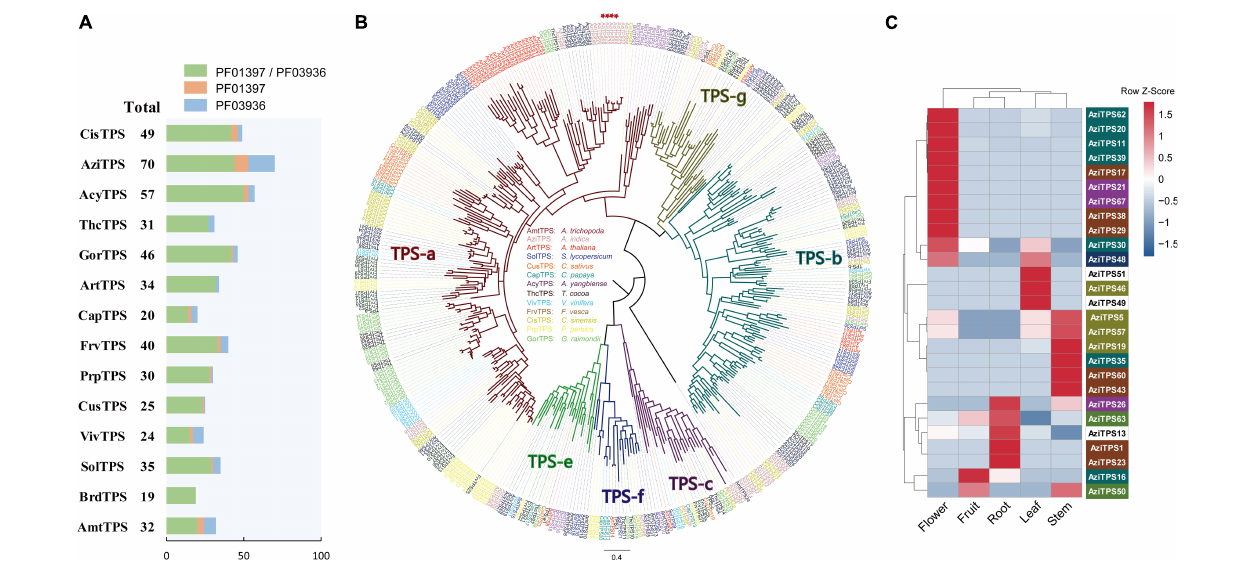
FIGURE 5 | Analysis of TPS gene family in A. indica . (A) Statistics of predicted TPS genes in A. indica and other 13 plants. (B) Phylogenetic analysis of TPS family members based on the protein sequences. A Maximum-Likelihood (ML) tree was generated from an alignment of 409 TPS protein sequences, comprising 403 putative TPSs from A. indica and other 13 plants (the remaining TPS genes were too short for meaningful alignment) and other six reported TPS genes belonged to TPS- a (AAX16121.1), b (AAQ16588.1), c (AAD04292.1), e (Q39548.1), f (Q93YV0.1), and g (ADD81294.1) subfamilies. The A. indica TPS genes are highlighted by red stars. (C) A. indica TPS genes substantially expressed in five tested organs (root, flower, fruit, leaf, and stem). The color of TPS genes depends on the subfamily